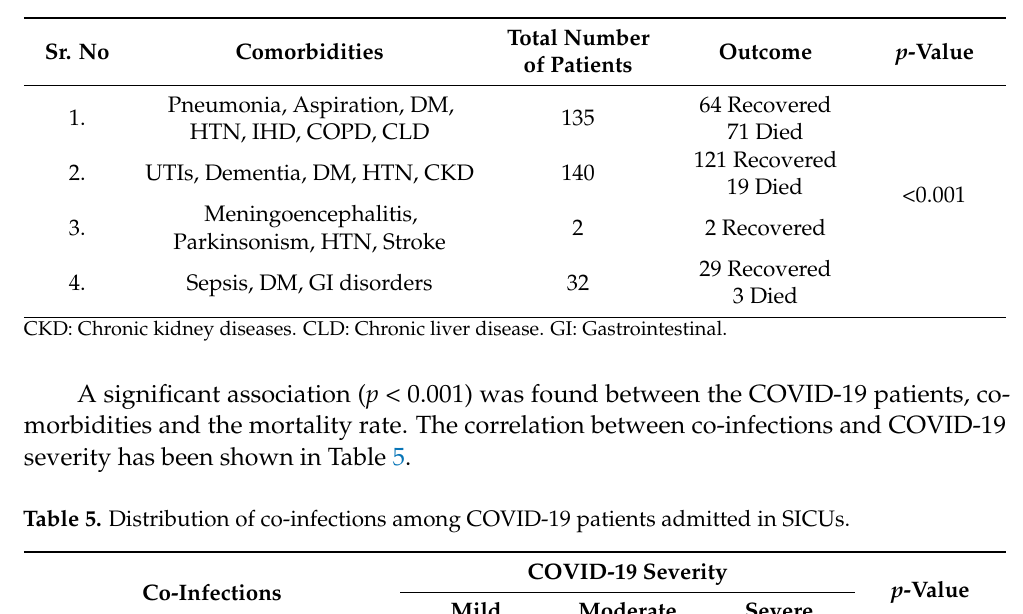
Table 4. Distribution of comorbidities among COVID-19 patients admitted in the intensive care unit and their outcome.